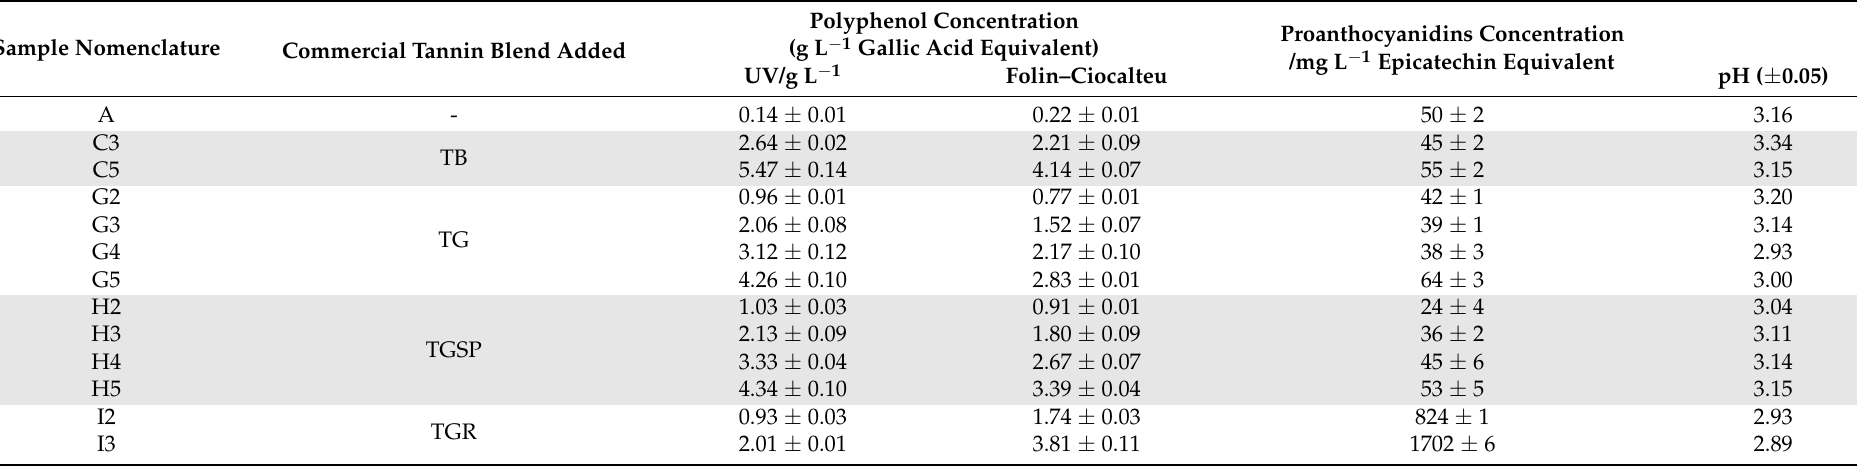
Table 2. Winery solutions used for QCM-D measurements: sample nomenclature, commercial tannin blend added to the base wine, polyphenol concentration measured via UV spectrophotometry (reading at 280 nm) and with the Folin–Ciocalteu method, proanthocyanidins concentration measured via the Bate–Smith method, measured pH; each value represents mean ± standard deviation ( n =